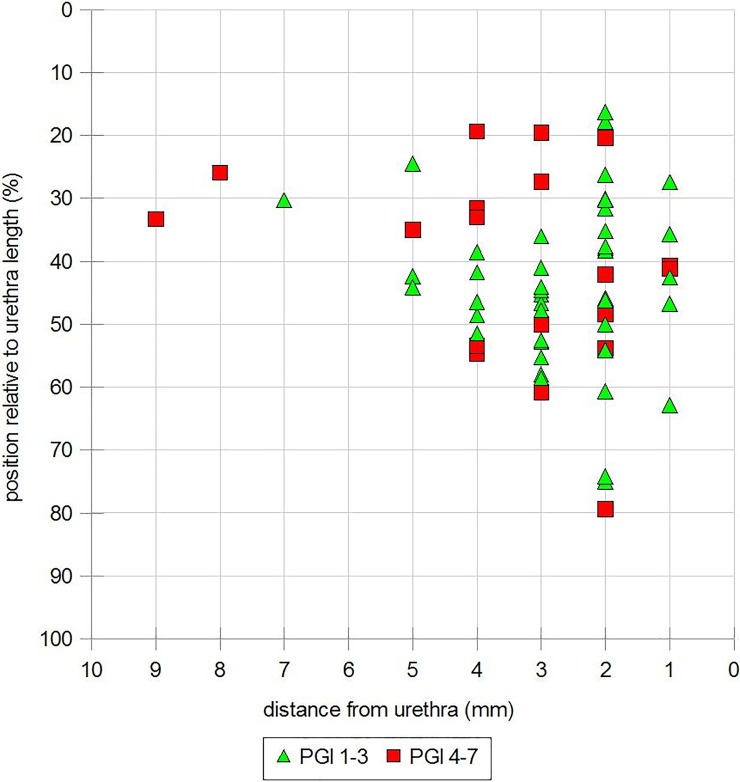
Cured vs. none-cured women according to the PGI-I dependent on tape position relative to TUD and TP.